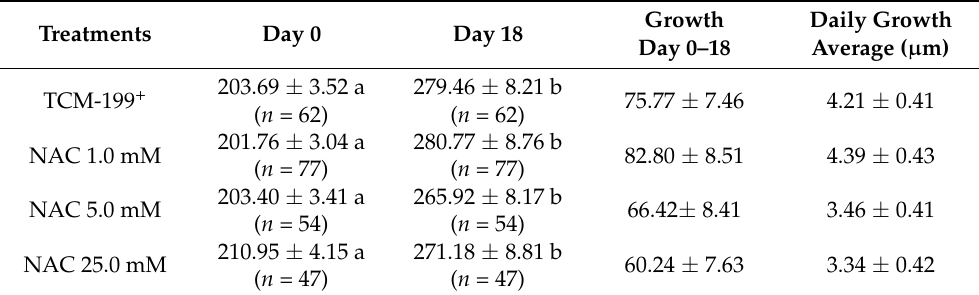
Table 1. Percentages of morphologically normal follicles, antrum formation, and growing follicles after 18 days of in vitro culturing in TCM-199 + alone or with different concentrations of NAC. Morphologically Antrum Formation Growing Follicles Treatments Normal Follicles TCM-199 + 97.97% (97/99) 20.20% (20/99) 62.63% (62/99) a NAC 1.0 mM 100.00% (101/101) 29.70% (30/101) 76.24% (77/101) b NAC 5.0 mM 100.00% (99/99) 24.24% (24/99) 54.55% (54/99) ac NAC 25.0 mM 98.98% (98/99) 29.29% (29/99) 47.47% (47/99) c